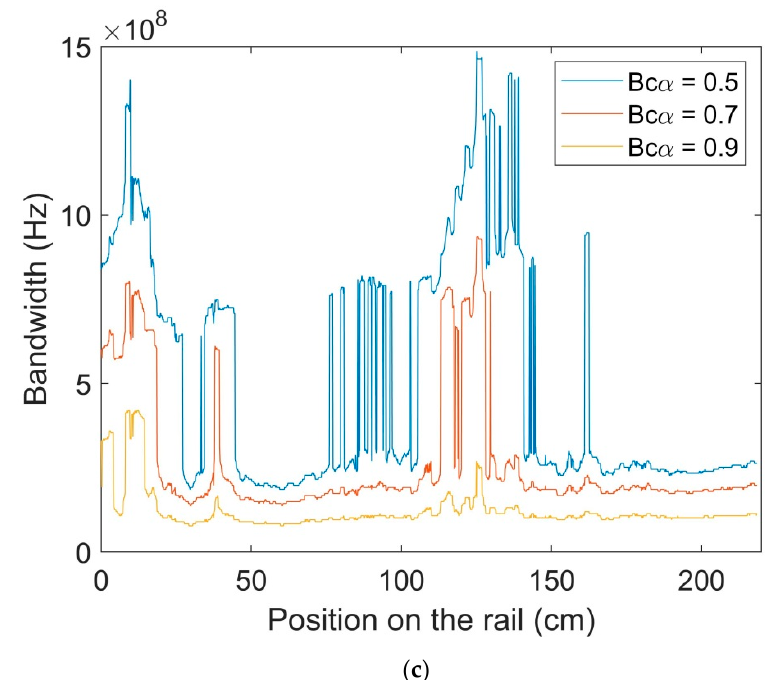
( c ) Figure 13. Coherence bandwidth as a function of the receiver position on the rail at 60 GHz received by ( a ) antenna 2; ( b ) by antenna 3; ( c ) by antenna 4. Table 2. The 99th percentile of coherence bandwidth (MHz), in the